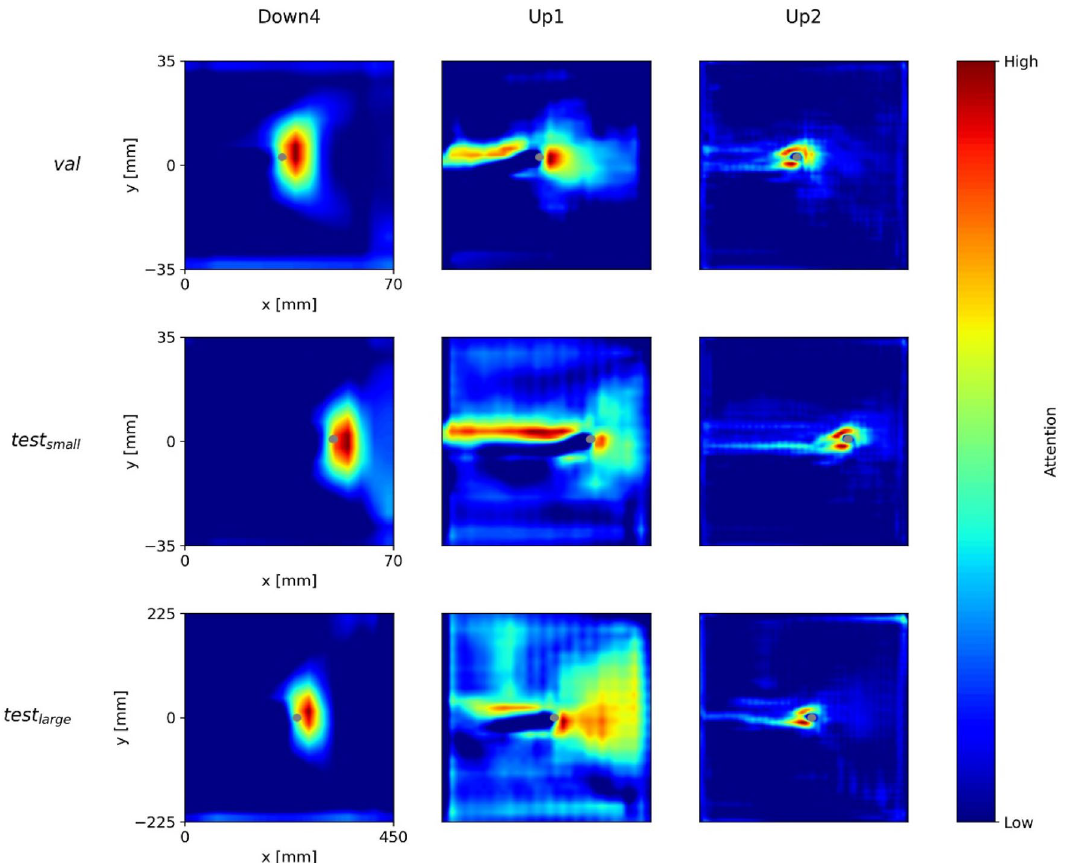
Figure 8. ParallelNets-1’s network attention of the layers Down4, Up1, and Up2 for the three DIC input samples